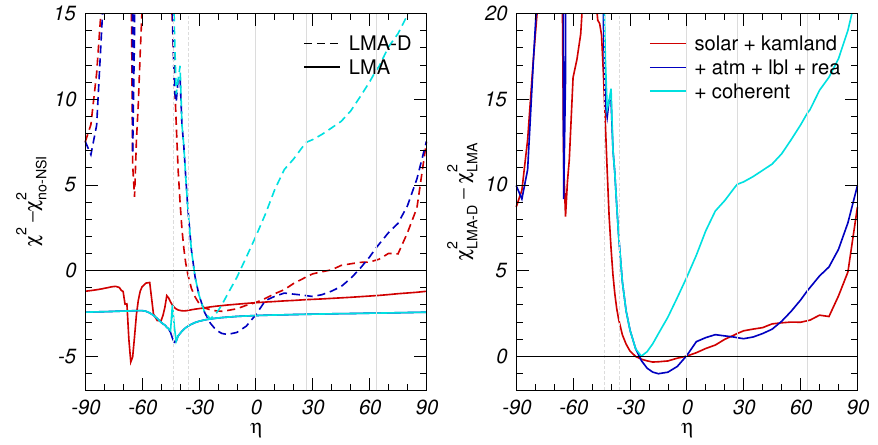
Figure 1 . Left: χ 2 ( η ) − χ 2 (full lines) and χ 2 ( η ) − χ 2 (dashed lines) for the LMA no-NSI LMA-D no-NSI analysis of different data combinations (as labeled in the figure) as a function of the NSI quark coupling parameter η . The full dark blue and light blue curves lie on top of each other. Right: χ 2 − χ 2 ≡ χ 2 ( η ) − χ 2 ( η ) as a function of η . See text for dark light LMA-D LMA